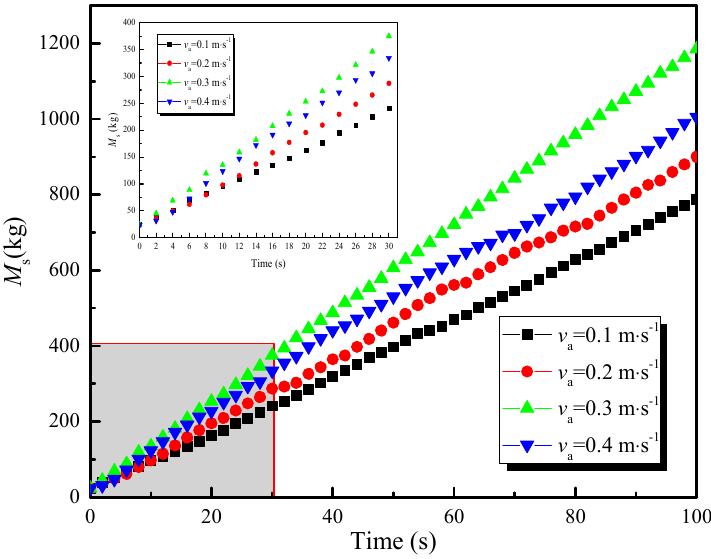
Figure 32. The variation in cumulative mass flow discharge with variations in the discharge velocity. Inset: the variation in cumulative mass export previous to 30 s.